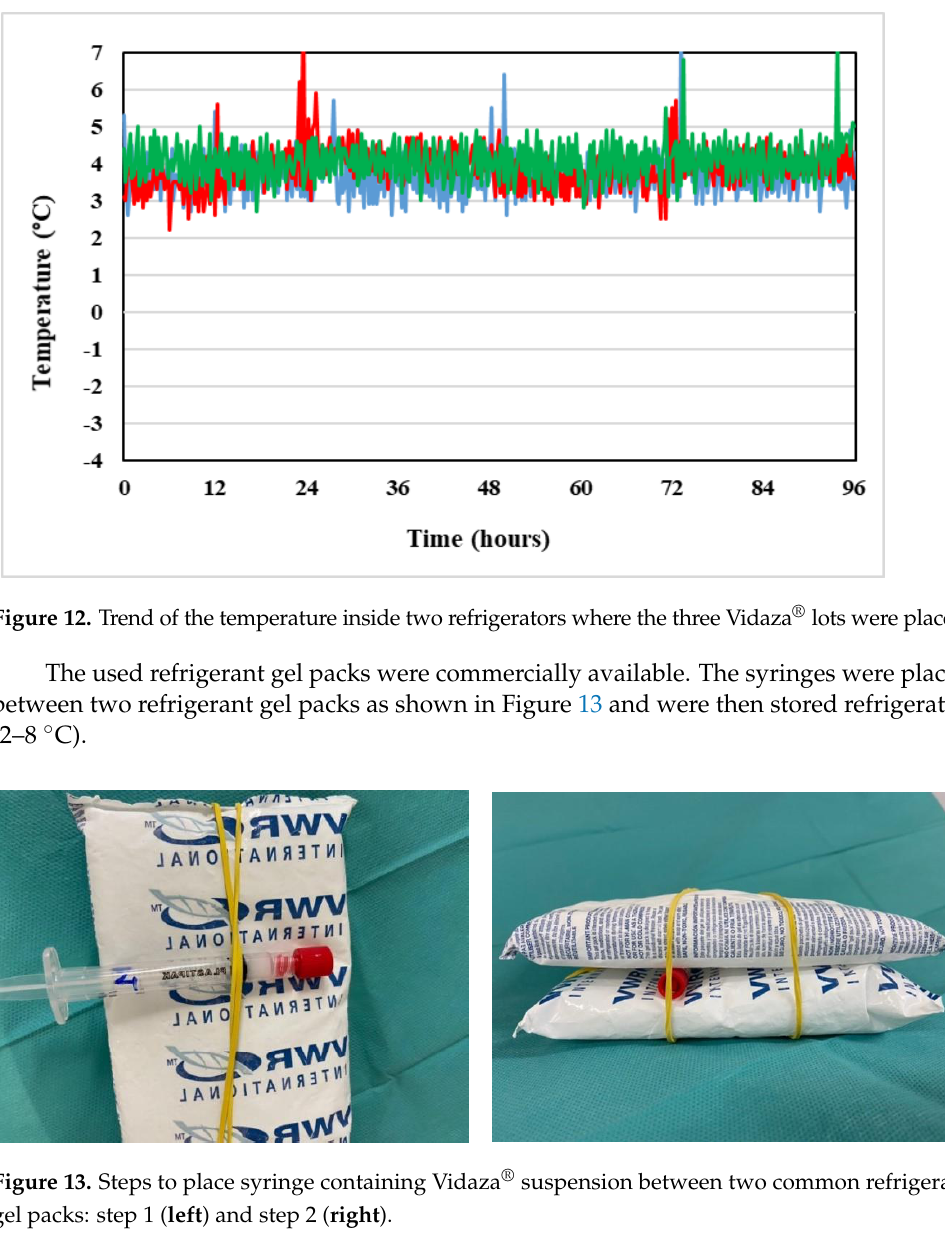
Figure 11. Trend of the temperature of the three Vidaza ® samples (red, green, and blue lines, respec- tively) stored refrigerated (2 – 8 °C) between two refrigerant gel packs, obtained placing a tempera- ture data logger into the polypropylene syringes in contact with the drug suspension.